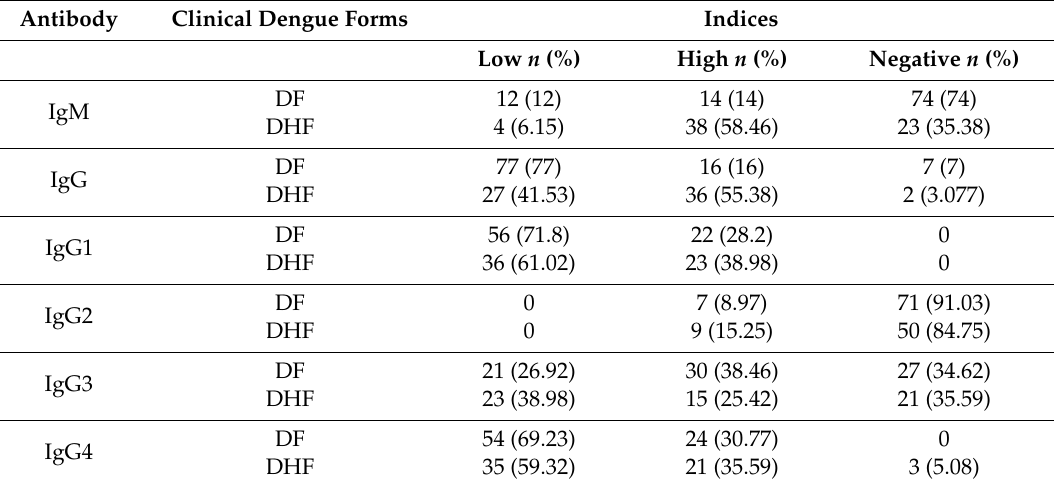
Table 2. Classification of antibody levels according to Tertile